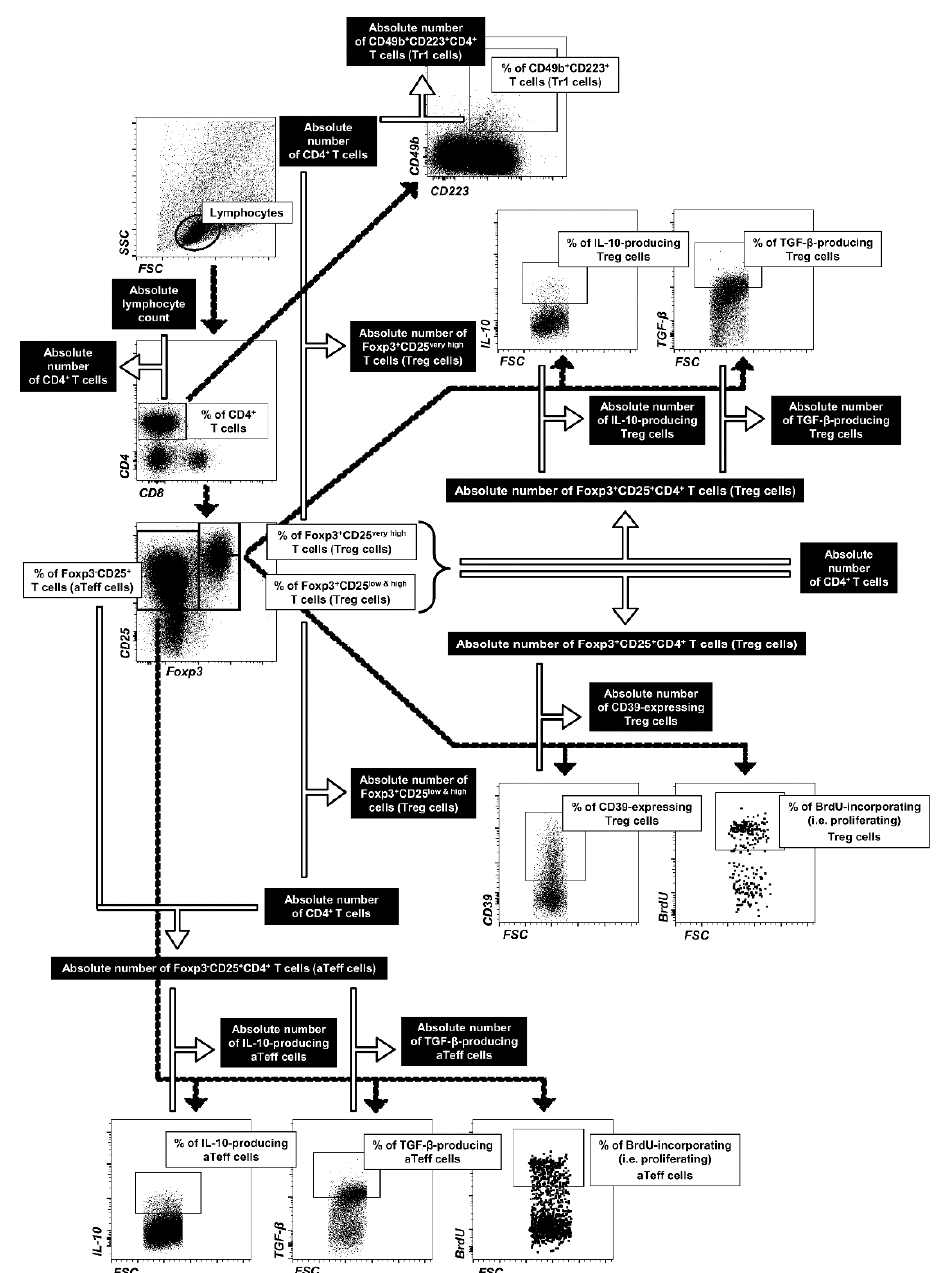
Figure 10. Gating strategy for flow cytometric data analysis and calculation of the absolute cell counts of lymphocyte subsets. Lymphocytes were identified based on forward and side scatter (FSC/SSC) properties, and then gated for expression of CD4 surface receptor. CD4 + T cells were analyzed for expression/co-expression of CD25 and Foxp3. On this basis, Foxp3 + CD25 + CD4 + and Foxp3 − CD25 + CD4 + T cells, i.e., regulatory (Treg) and activated effector (aTeff) T cells, respectively, were distinguished. Subsequently, IL-10- and TGF-β-producing cells as well as 5-bromo-2-deoxyuridine(BrdU)-incorporating cells were identified within these cell subsets. Moreover, CD39-expressing cells were identified within Treg cell subset. In addition, type 1 regulatory T (Tr1) cells were detected on the basis of CD49b and CD223 co-expression within CD4+ T cell subset. Absolute cell counts of lymphocyte subsets (i.e., number of cells from particular subpopulations per sample well) were calculated using the dual platform method, as shown above.